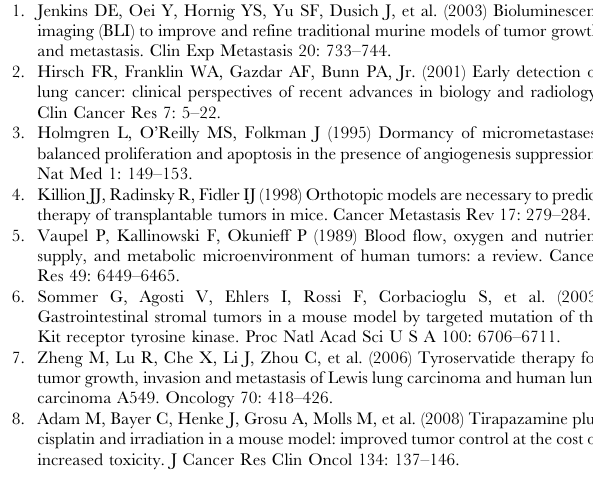
Figure S4 (A, B) Bioluminescent signal of a single 4T1-luc2-1A4 cell in vivo . Female nu/nu mouse was implanted with a single 4T1- luc2 cell subcutaneously in the dorsal region. Mouse was imaged prior to D-luciferin injection (A). Ten minutes after the D-luciferin injection, whole mouse image was taken (FOV; C, binning; small, f stop; 1, exposure time; 5 min) (B). Dotted circle indicates the signal from the implanted cell. (C) Whole mouse ( nu/nu ) image with implanted ten 4T1-luc2-1A4 cells. The exact number of cells was picked up by a glass capillary pipet and was injected into the back of the mouse subcutaneously, through a skin incision. (D) Magnified image of dotted area from panel C. Dotted circle indicates the signal from 10 cells. Asterisk (*) indicates the skin incision